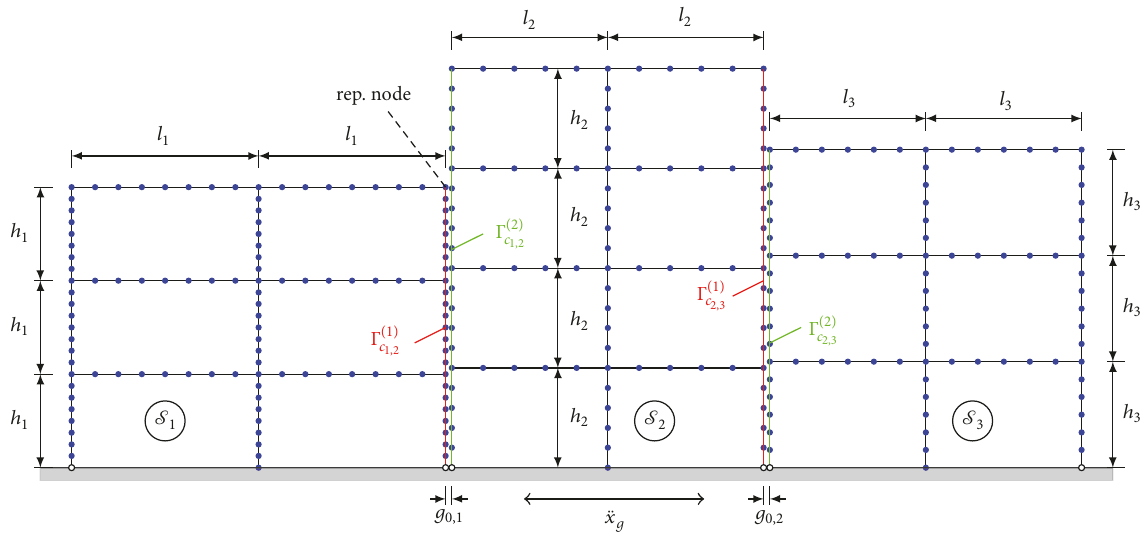
Figure 2: Dynamic system of adjacent structures; frame height measures ℎ 1 , ℎ 2 , and ℎ 3 ; frame width measures 𝑙 1 , 𝑙 2 , and 𝑙 3 ; initial gap 𝑔 0,1 ; initial gap 𝑔 0,2 ; representative output node (rep. node); contact surfaces Γ (1) 𝑐